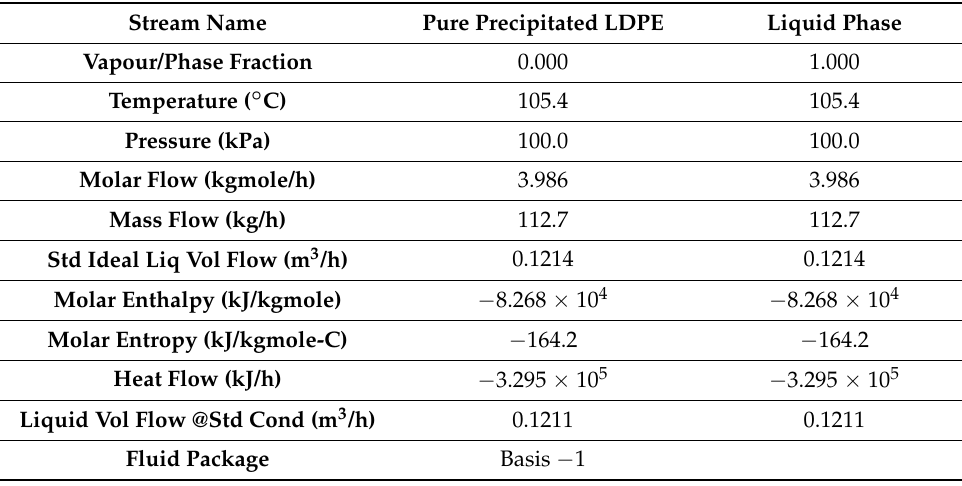
Table 9. Conditions of pure precipitated